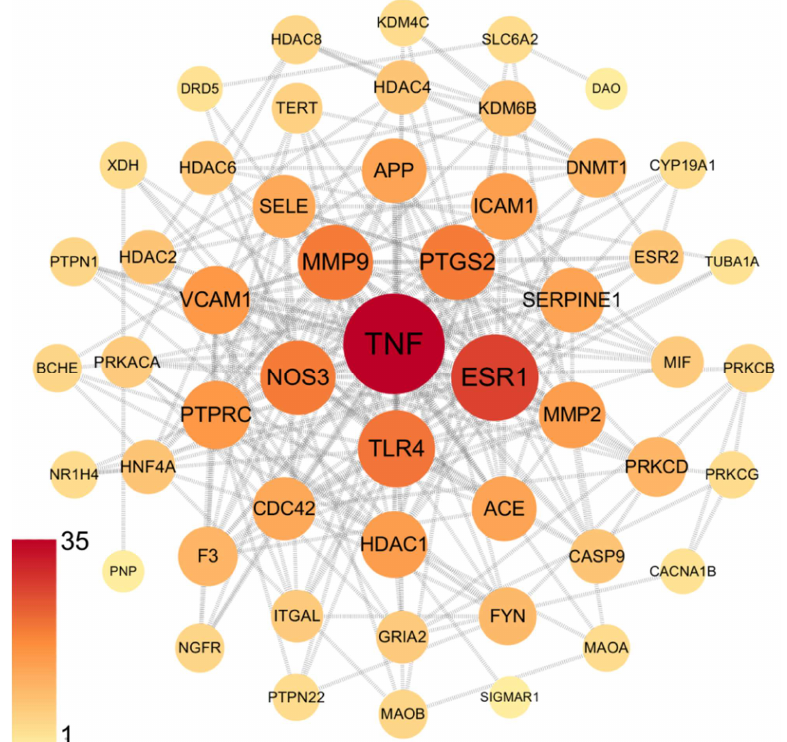
Figure 4. Protein–protein interaction (PPI) network analysis showing 52 intersection targets. The size of the node degree value is indicated by the size and color of the nodes. The larger the node and the deeper the color red represents the higher degree value of the node.